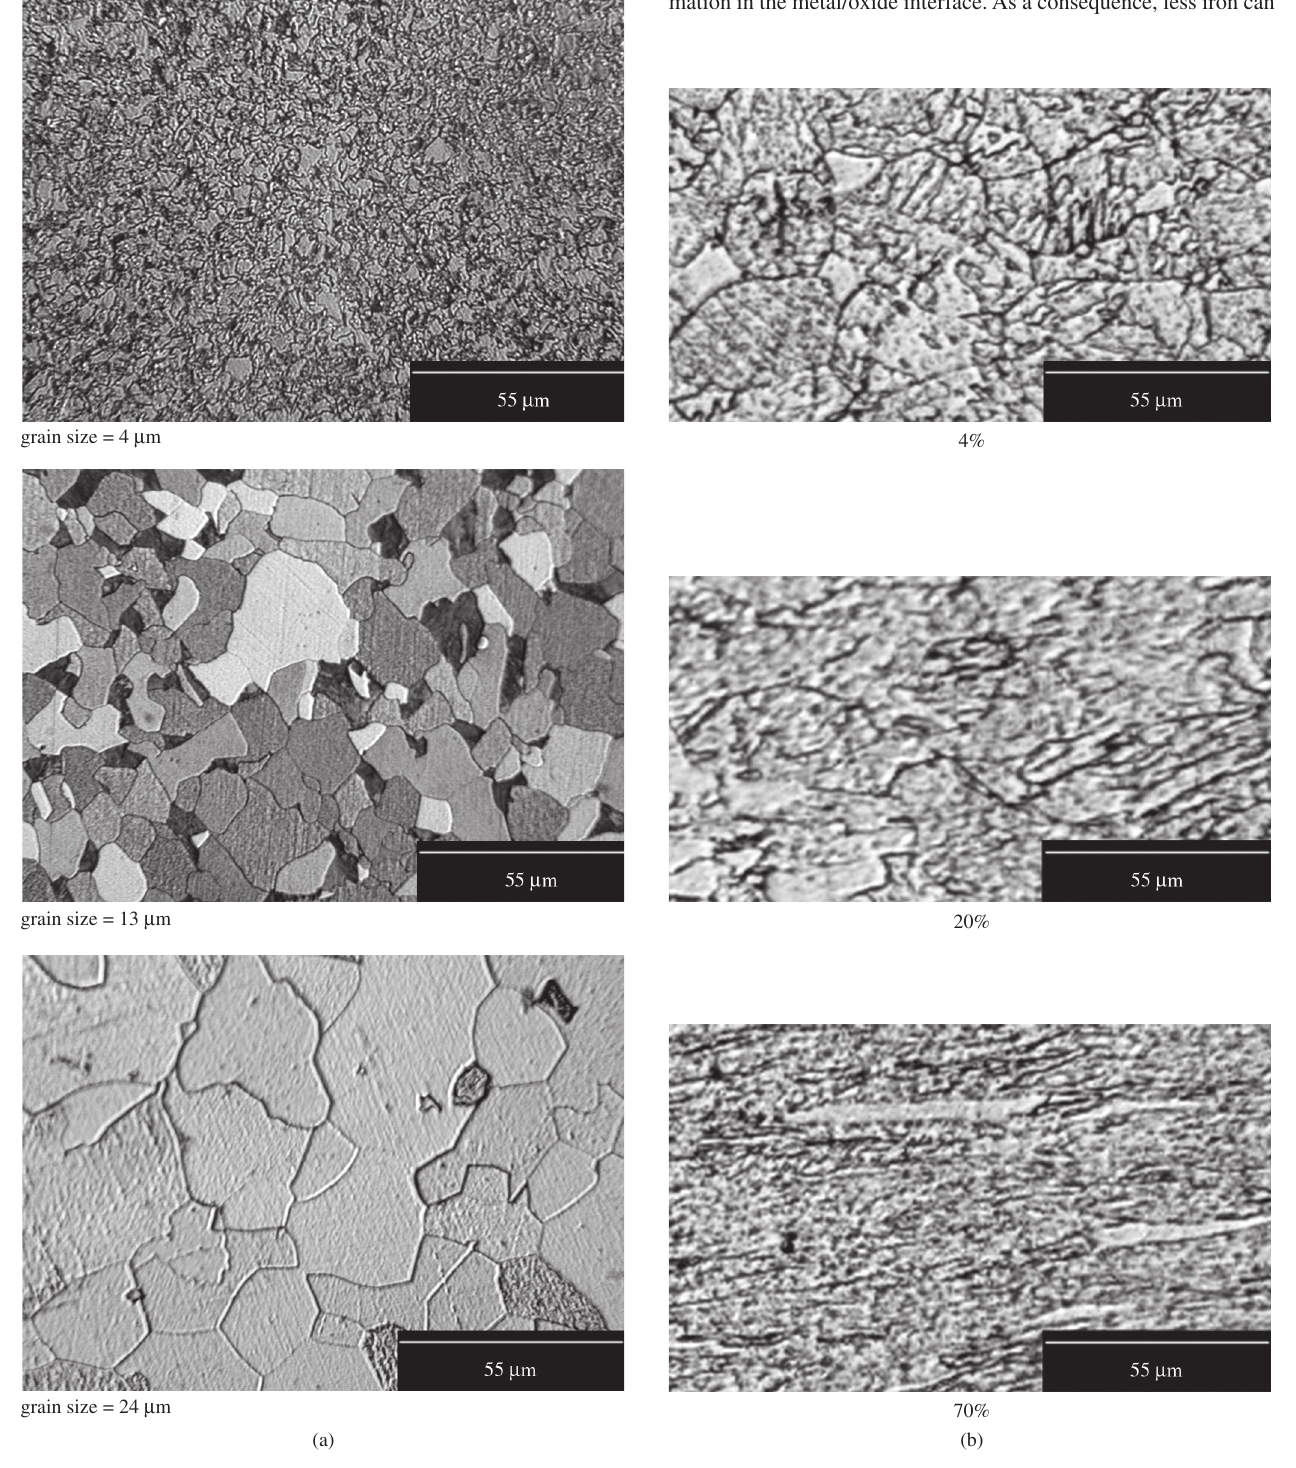
Figure 2. Optical microscopy observation of the microstructure of the 2.25Cr1Mo before oxidation; a) after annealing in inert atmosphere; and b) after cold